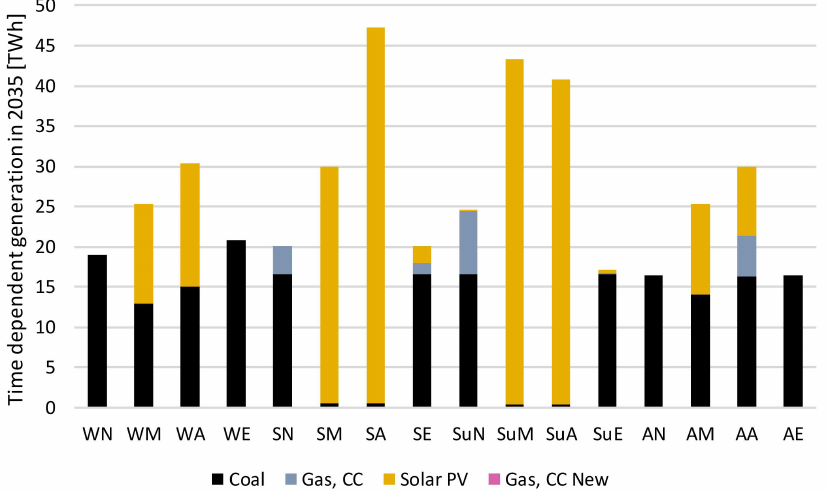
Figure 6. Generation (TWh) by time slice in 2035 in the RETarget scenario—without code modifications.